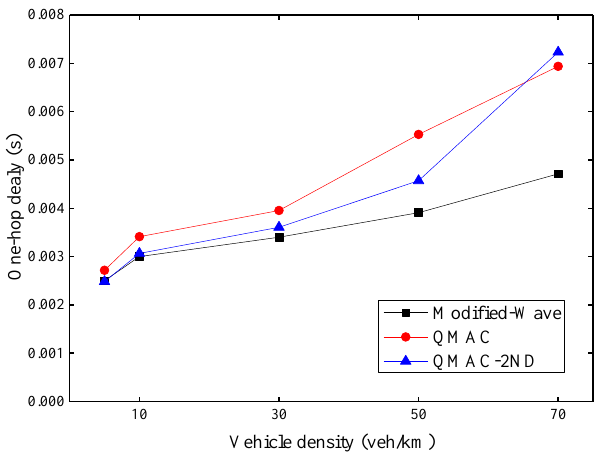
Figure 10. Average one-hop delay under different vehicle densities.